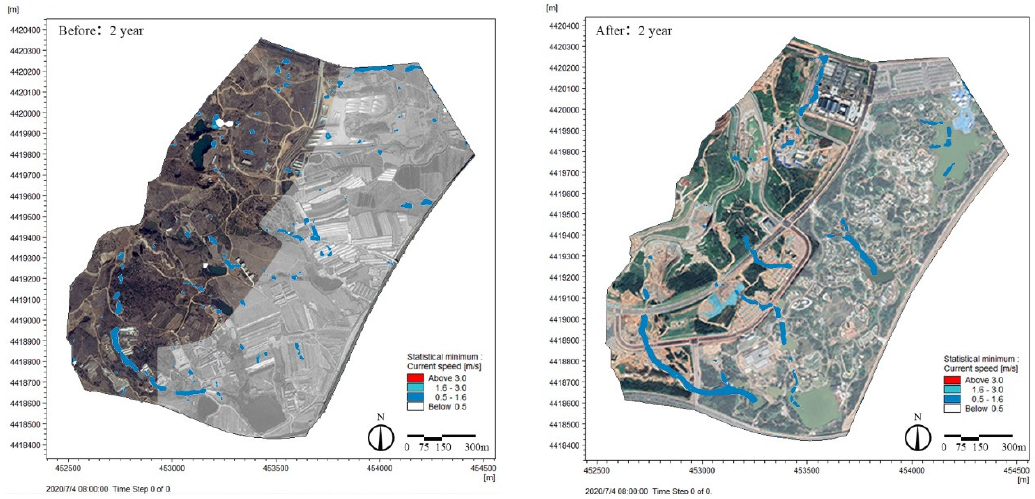
Figure 11. Comparison of maximum flow velocity under rainfall in different return periods before and after construction. Notes: The comparison chart of other rainfall events is annexed.